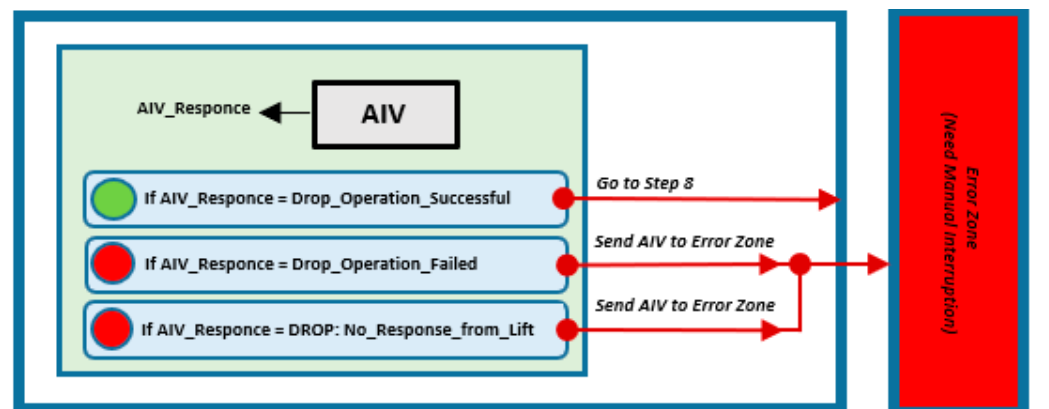
Figure 16. Drop product.